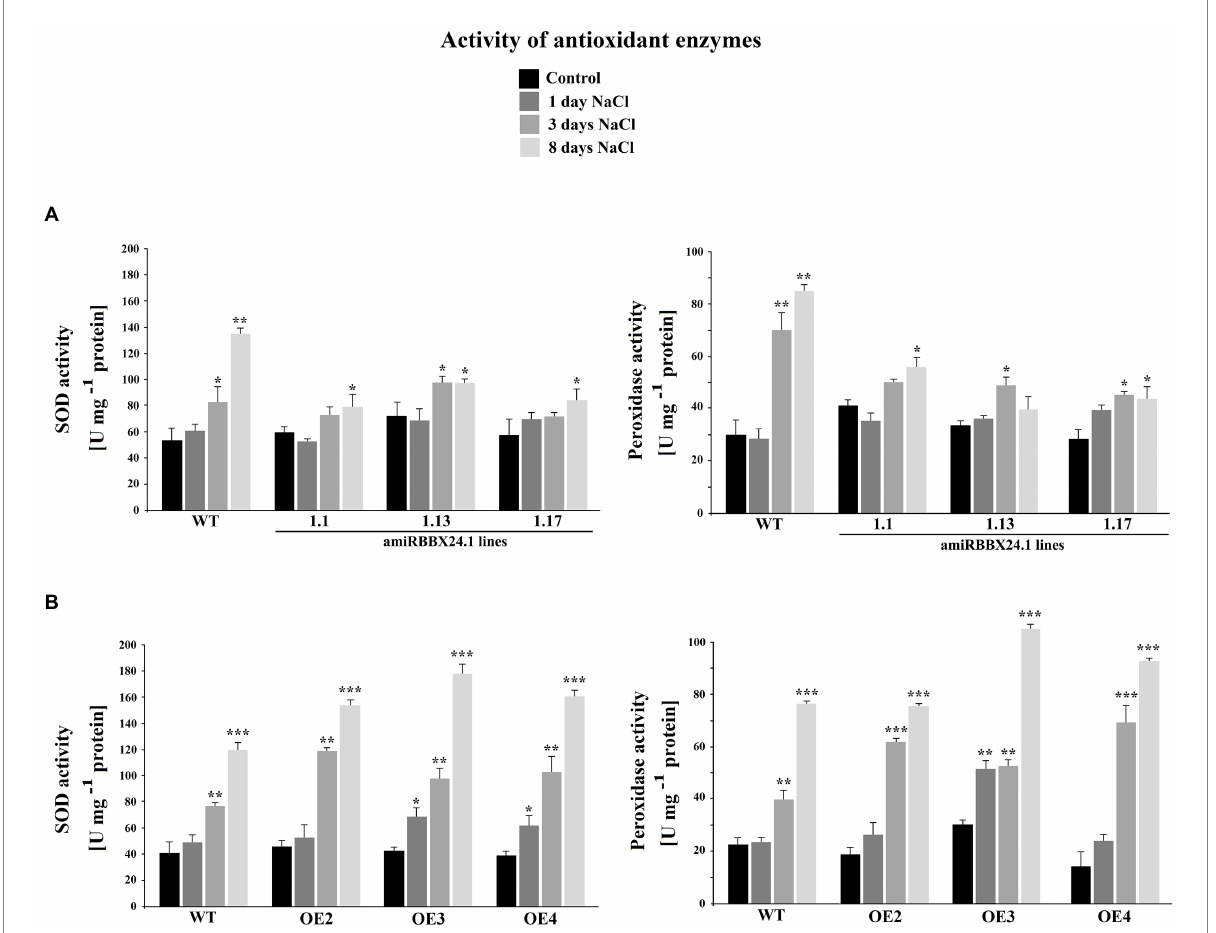
FIGURE 6 The activity of superoxide dismutase (SOD, EC 1.15.1.1) and peroxidase (POX, EC 1.11.17) enzymes in StBBX24 -silenced (A) and -overexpressing (B) S. tuberosum lines subjected to salt stress. Antioxidant enzymes activity of phytotron-grown S. tuberosum WT, amiRBBX24.1.1, amiRBBX24.1.13 and amiRBBX24.1.17 plants, and StBBX24 -OE2, StBBX24 -OE3 and StBBX24 -OE4 lines in high salt conditions (0.15 M NaCl). Measurement of superoxide dismutase and peroxidase activity was performed as described in Materials and methods. Error bars represent the bar errors. Statistical analysis was performed using the t -test (Statistica program, version 10). *, ** and ***, values significantly different from the control (C) value with p < 0.05, p < 0.01 and p < 0.001, respectively. WT,